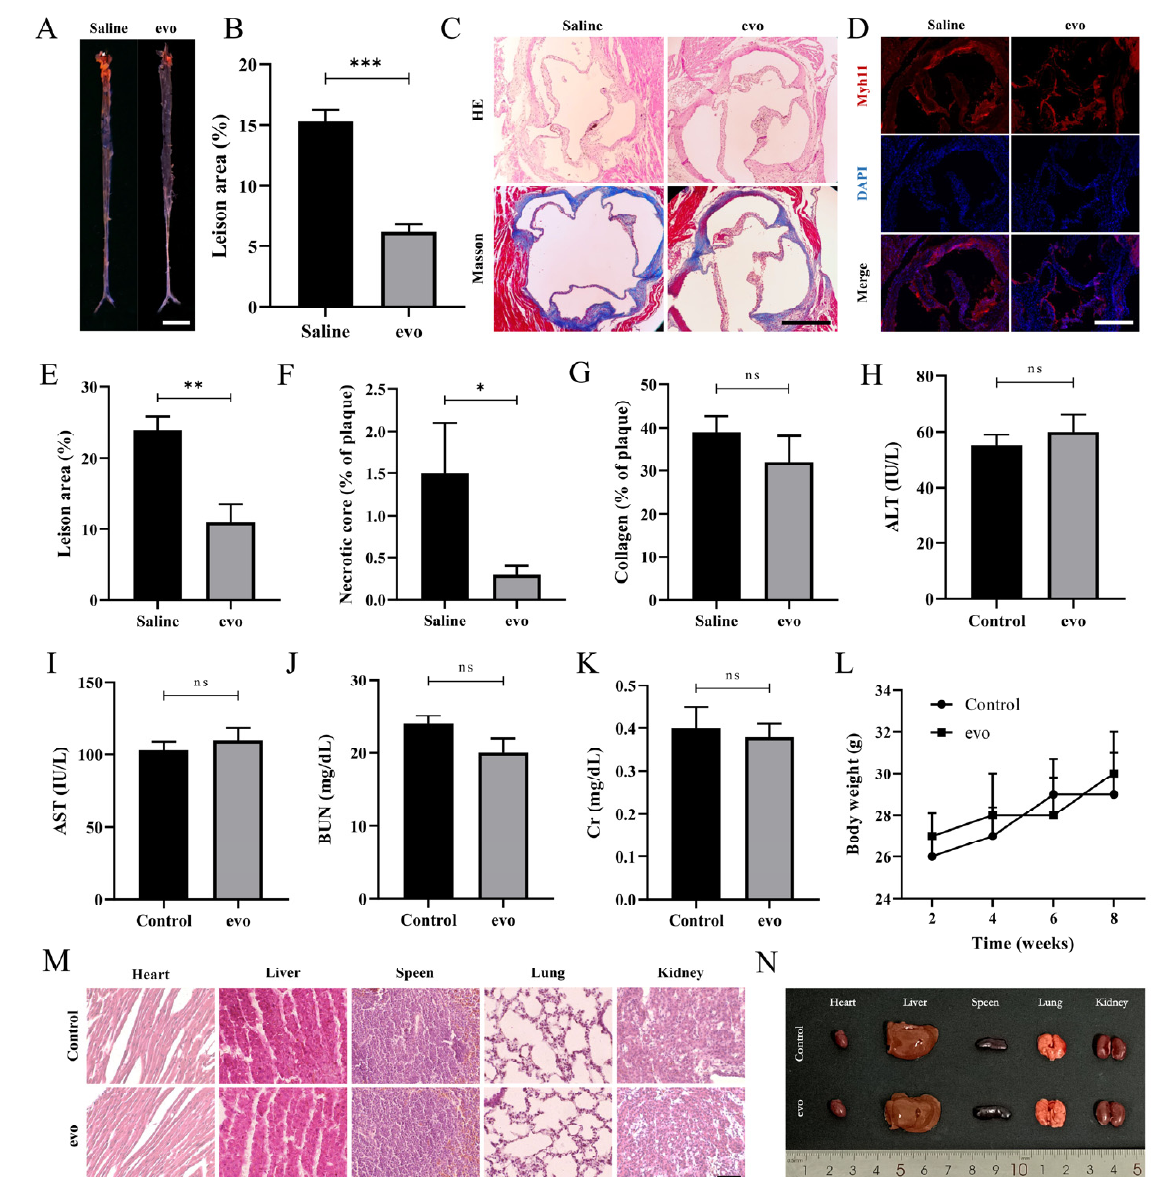
Figure 1. Analysis of aortic plaques and evodiamine toxicology in mice: ( A , B ) images taken of aortic Sudan 4 staining and quantification. Scale bars in ( A ), 1 cm. ( C , E – G ) The paraffin sections of aortic roots were stained with H&E and Masson and the stained regions were quantified. ( D ) The cross-section of the aortic root was analyzed by immunofluorescence staining. ( H – L ) Liver and kidney function tests and weight measurements. Scale bars in ( C , D ), 500 µ m. ( M , N ) H&E staining and appearance of organs. Scale bars in ( M ), 50 µ m. The number of mice in each group was six. The bar graphs depict means ± SEM; statistical significance * p < 0.05, ** p < 0.01, *** p < 0.001 and ns p > 0.05 by the one-way ANOVA test.